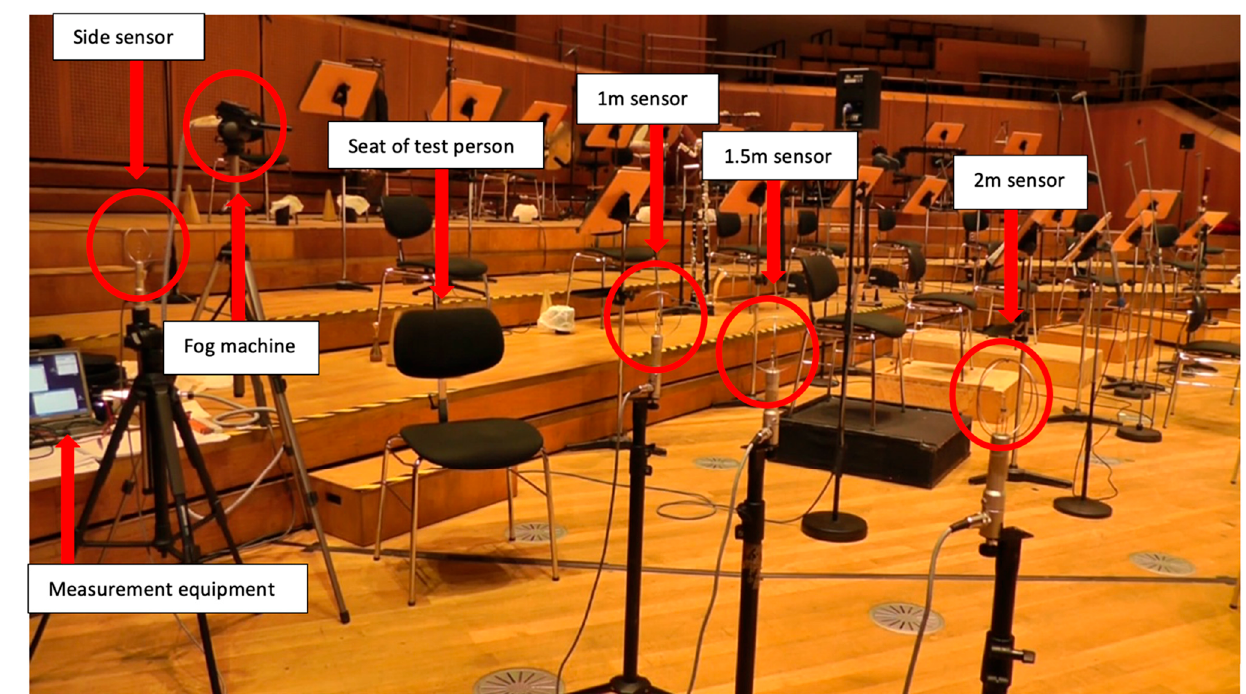
Figure A2. Distance measurements with three sensors in the direction of the instrument’s bell.